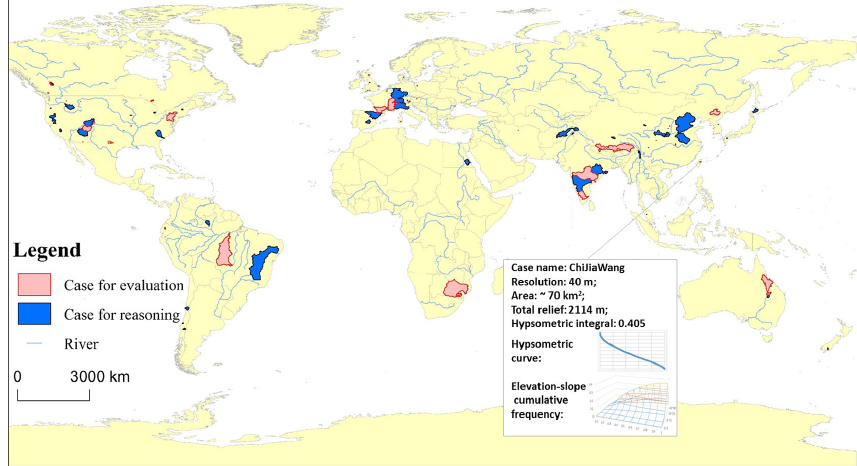
Figure 3. Spatial distribution of the cases used in this study (the box in the map shows an example of a formalized